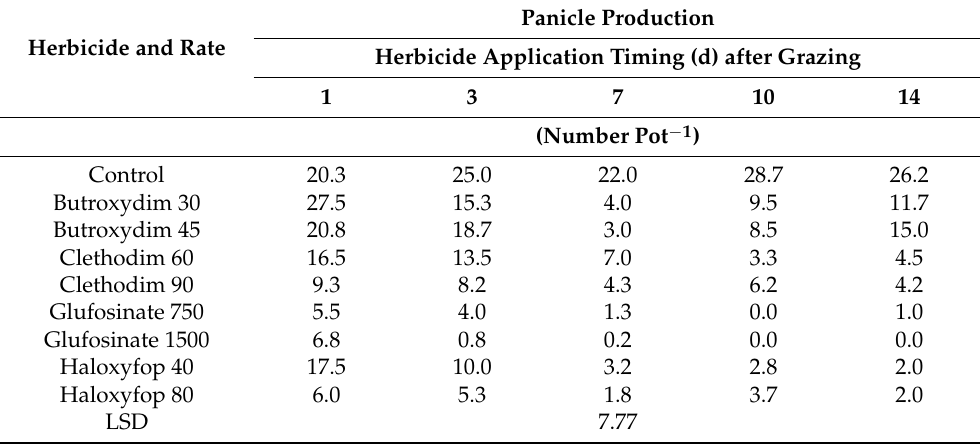
Table 5. The interaction effect of herbicide treatment and their application timing (1, 3, 7, 10, and 14 d after grazing) on the panicle production (number pot − 1 ) of Chloris virgata .